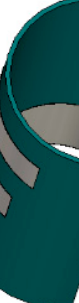
Figure 10. Proposed antenna in a bending condition (side-by-side).